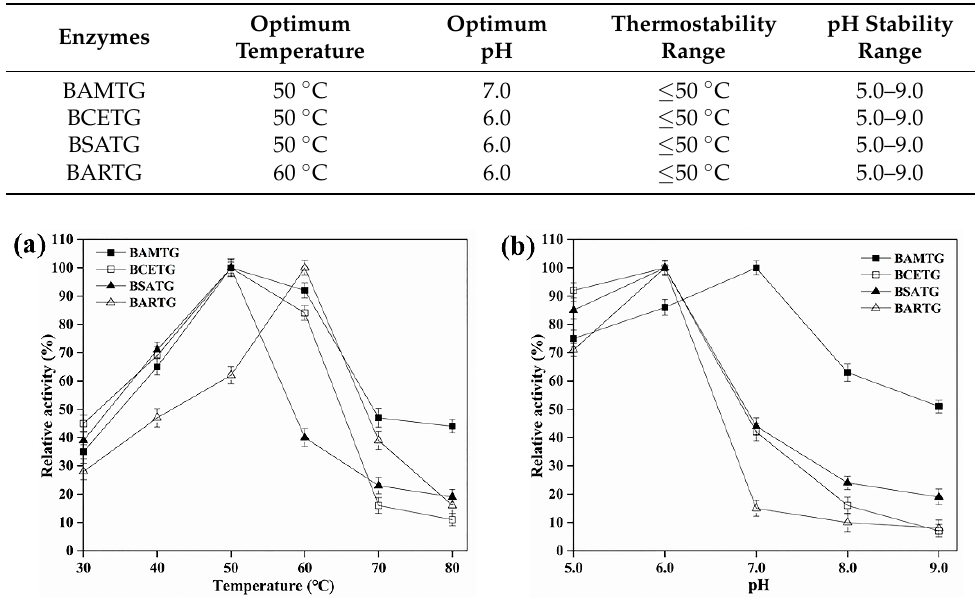
Table 1. The summarized biochemical characterization of recombinant TGs.